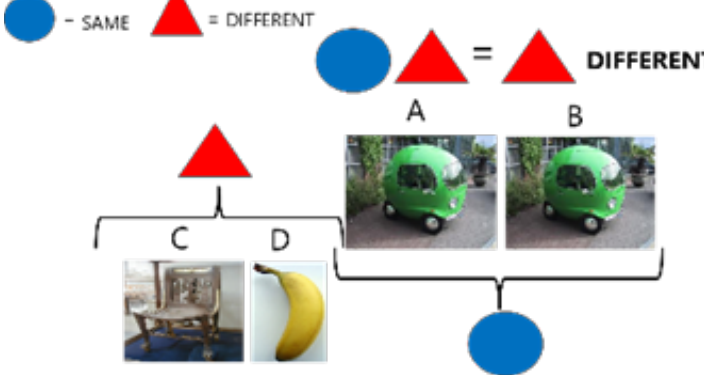
Plastic Tokens Associated with Pairs of Pictures that are the Same and Different,